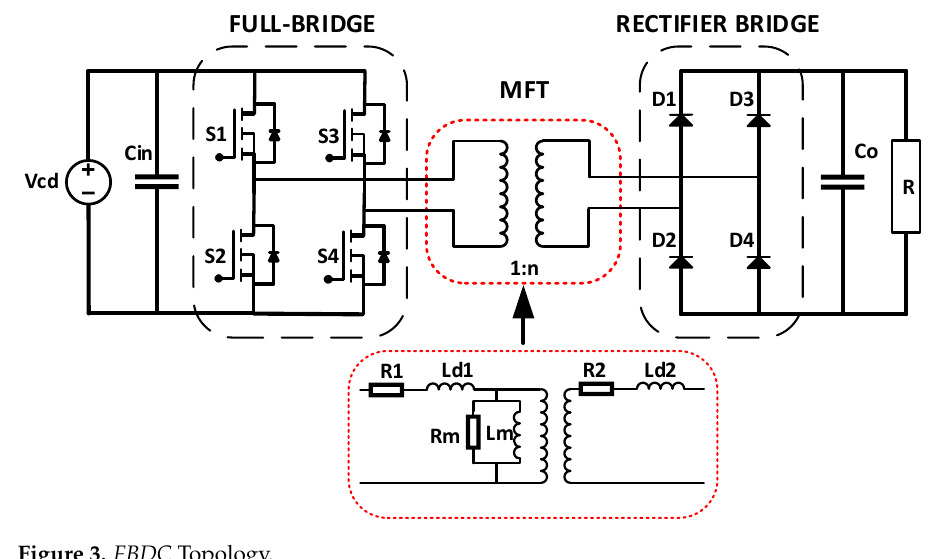
Figure 4. Modulation signals: ( a ) 2L, ( b ) 3L.